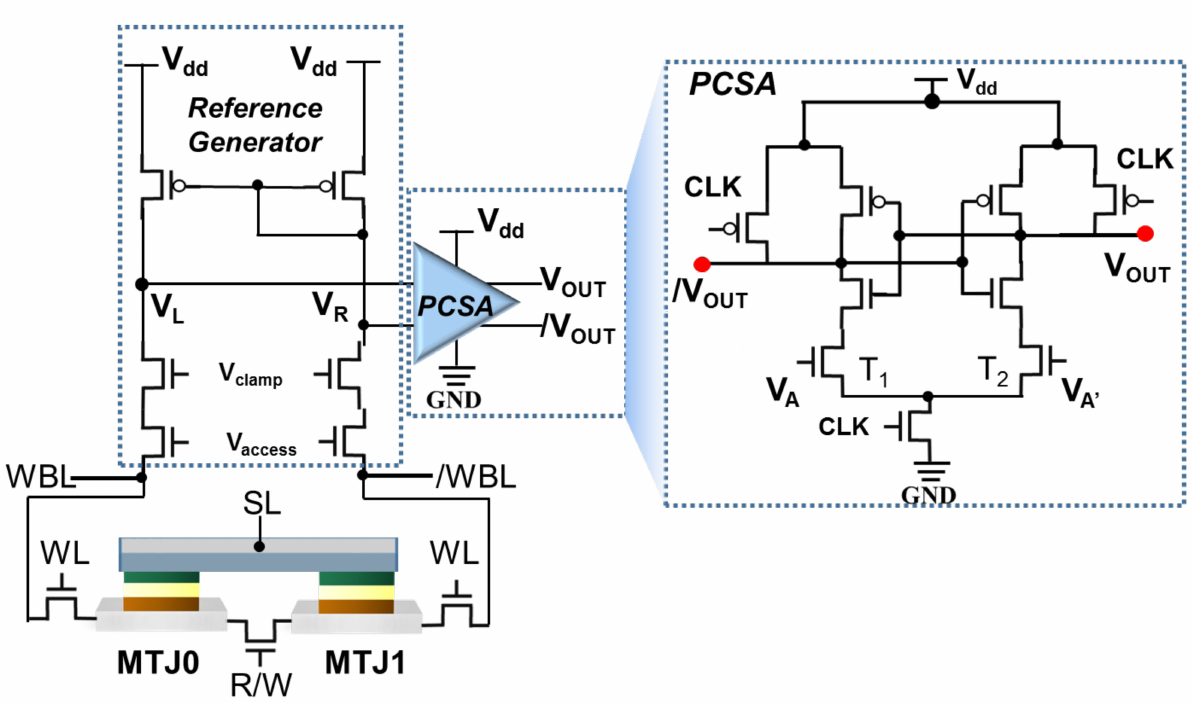
Figure 4. Read/write circuit architecture for 3T2M FGT-MTJ memory cell. Schematic diagram of the logic operation sub-circuit structure with an asymmetric PCSA